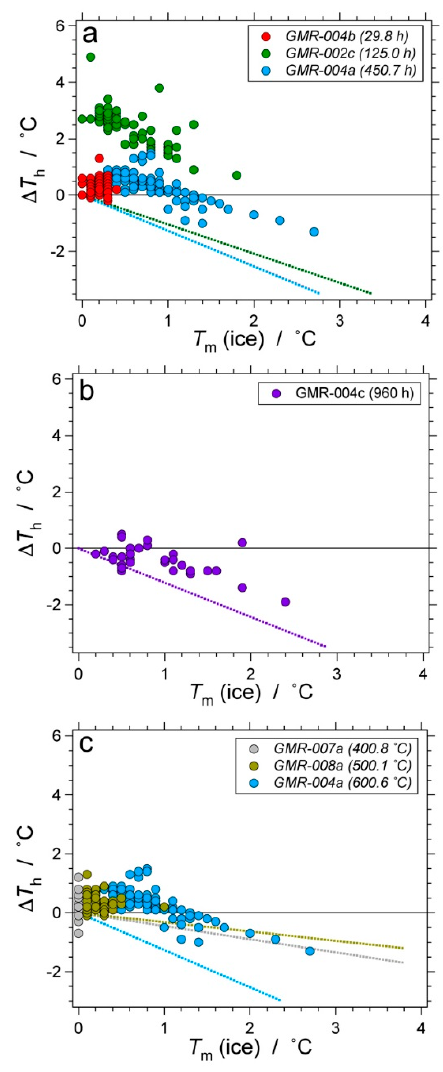
Figure 9. Modification of T h ( Δ T h ) versus T m of individual fluid inclusions after the re-equilibration experiments with: ( a ) a variety of run-times at about 600 °C and 336 MPa ( GMR-004b , GMR-002c , GMR-004a ); ( b ) GMR-004c ; and ( c ) a variety of temperatures with about a 458-h run-time ( GMR-007a , GMR-008a , GMR004a ). The dashed lines represent the ideal mixing behavior of H 2 O and D 2 O.